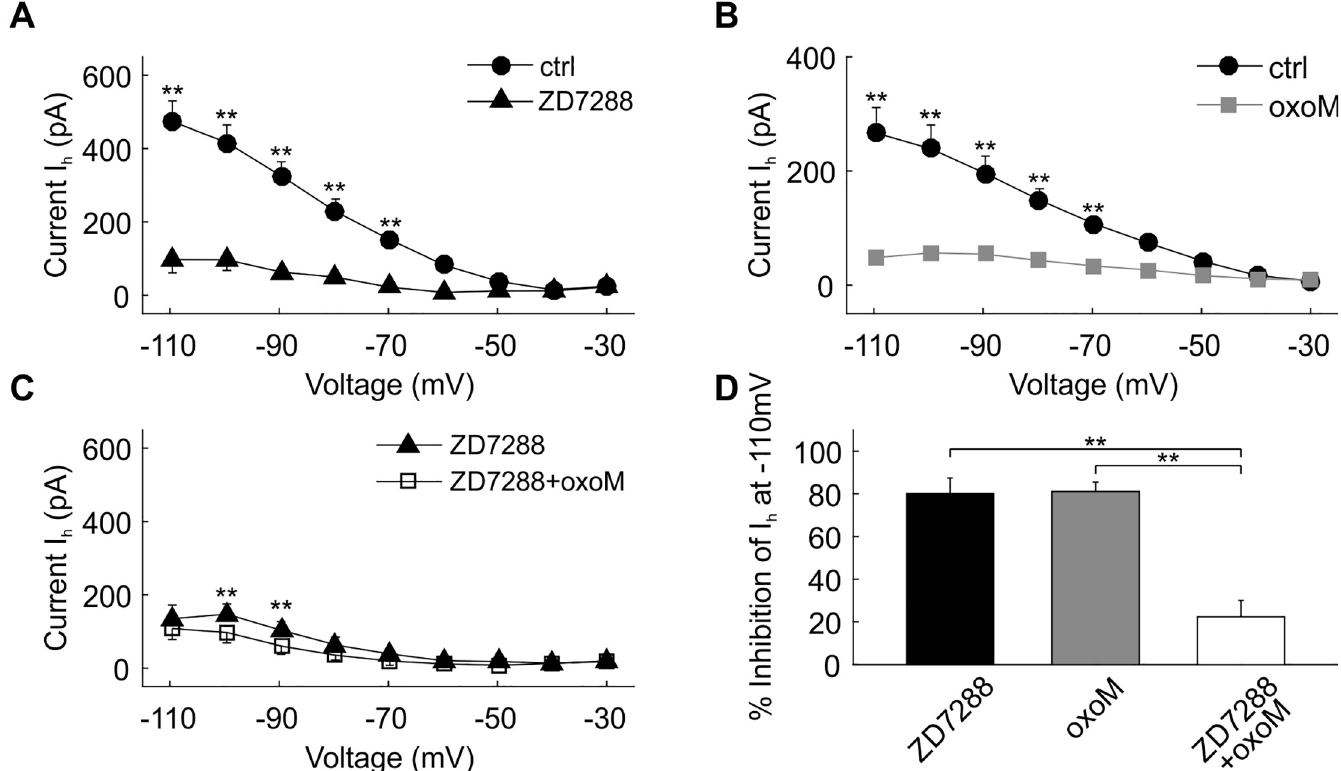
Fig 5. Quantification of I h suppression by oxoM in SBCs. (A) Voltage-current relationship of the mean of the current I h (n = 5) in control and after application of ZD7288. (B) Voltage-current relationship of the mean of the current I h (n = 5) in control and after application of oxoM. (C) Voltage-current relationship of the mean of the current I h (n = 6) in presence of ZD7288 and after application of oxoM. (D) Percentage inhibition of I h at -110 mV induced by the application of ZD7288 (black) or oxoM (grey) in control condition or by the application of oxoM in presence of ZD7288 (white). Application of ZD7288 or oxoM alone significantly reduced I h at -110 mV. Application of oxoM did not reduce I h when the cell was pre-treated with ZD7288. � p < 0.05; �� p < 0.01.